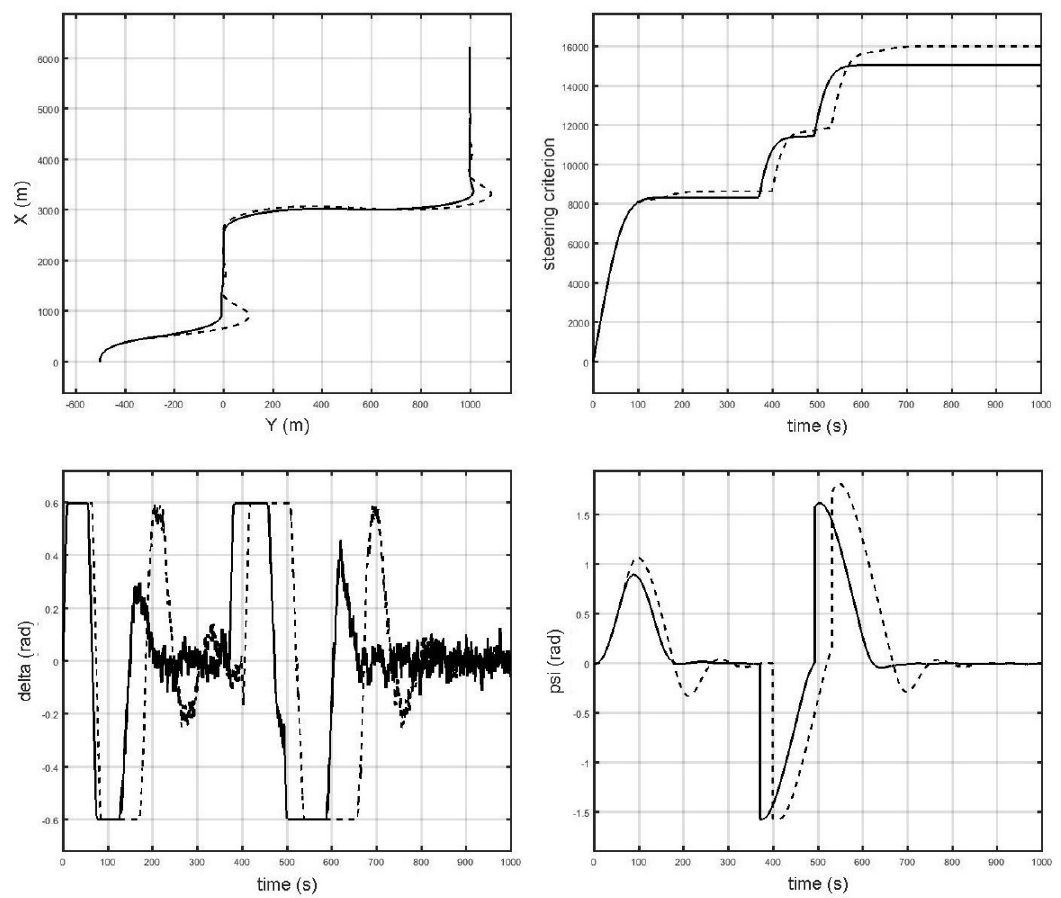
Figure 3. An example outcome of the comparison of the proposed adaptive system (continuous line) and linear quadratic regulator (LQR) regulator without model parameter identification (dashed lined).